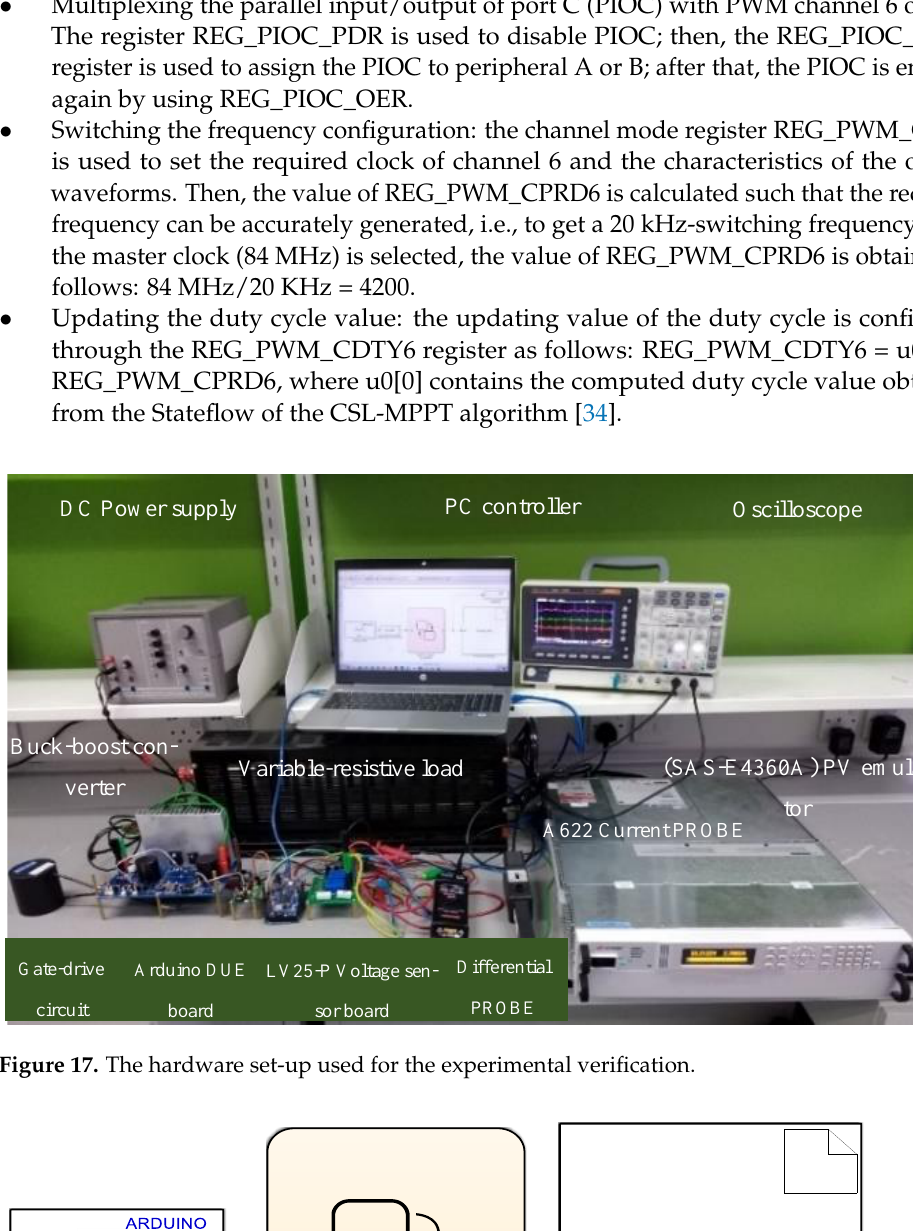
Figure 17. The hardware set-up used for the experimental verification.